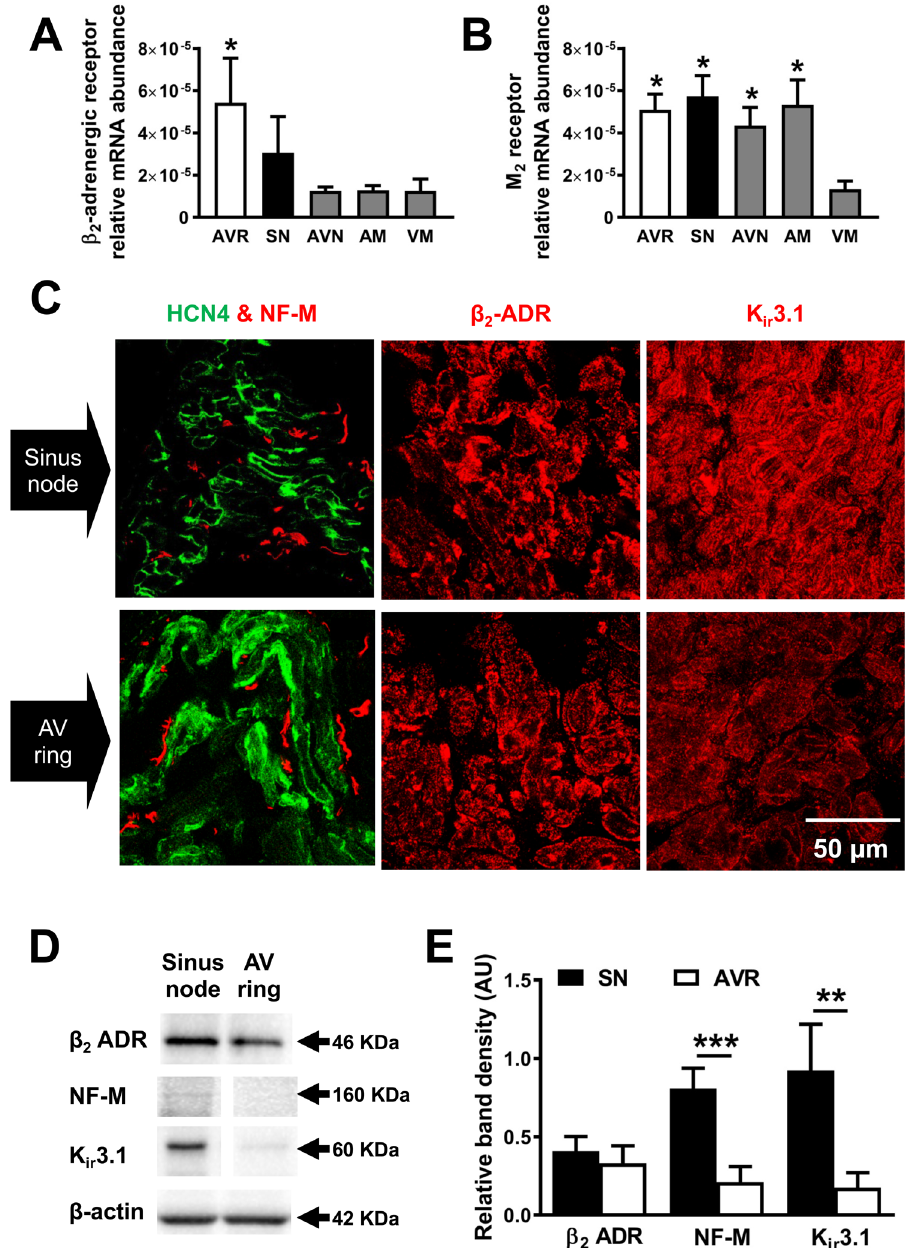
Figure 6. Adrenergic and muscarinic receptor gene and protein expression. ( A , B ) β 2 -adrenergic receptor ( β 2 -ADR) and M 2 -muscarinic receptor in atrioventricular ring (AVR), sinus node (SN), atrioventricular node (AVN), atrial muscle (AM) and ventricular muscle (VM). * P ≤ 0.05 vs . VM; n = 12 hearts. ( C ) Representative SN and AV ring sections labelled with HCN4 (green), neurofilament-M (NF-M; red), β 2 -ADR and K ir 3.1 (n = 5 hearts). Scale bar denotes 50 µ m. ( D ) Western blots of β 2 -ADR, NF-M, K ir 3.1 and β -actin in sinus node and AV ring. Blots cropped from different parts of the same gel, or from different gels are clearly delineated with white space. ( E ) Mean band densities relative to β -actin. Student’s t-test was used for statistical comparison and ** P ≤ 0.01, *** P ≤ 0.001; n = 4/5